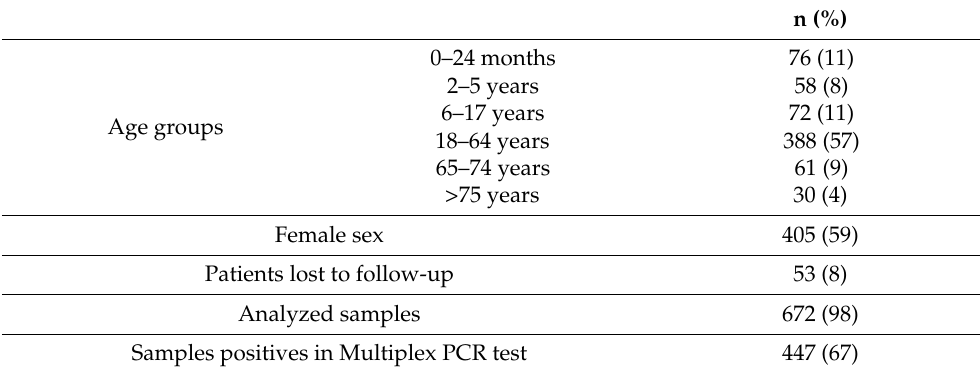
Table 1. Characteristics of the